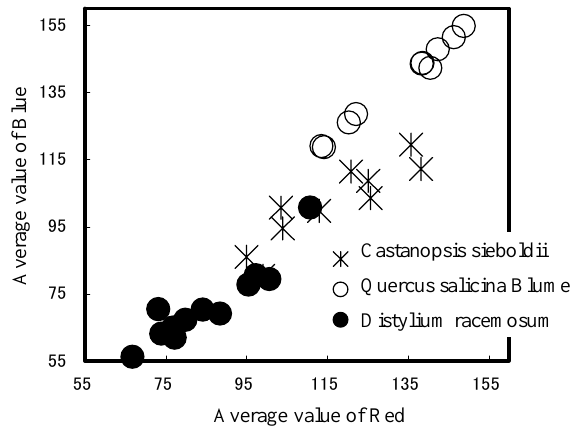
Figure 6. Result of Species Classification by Colour